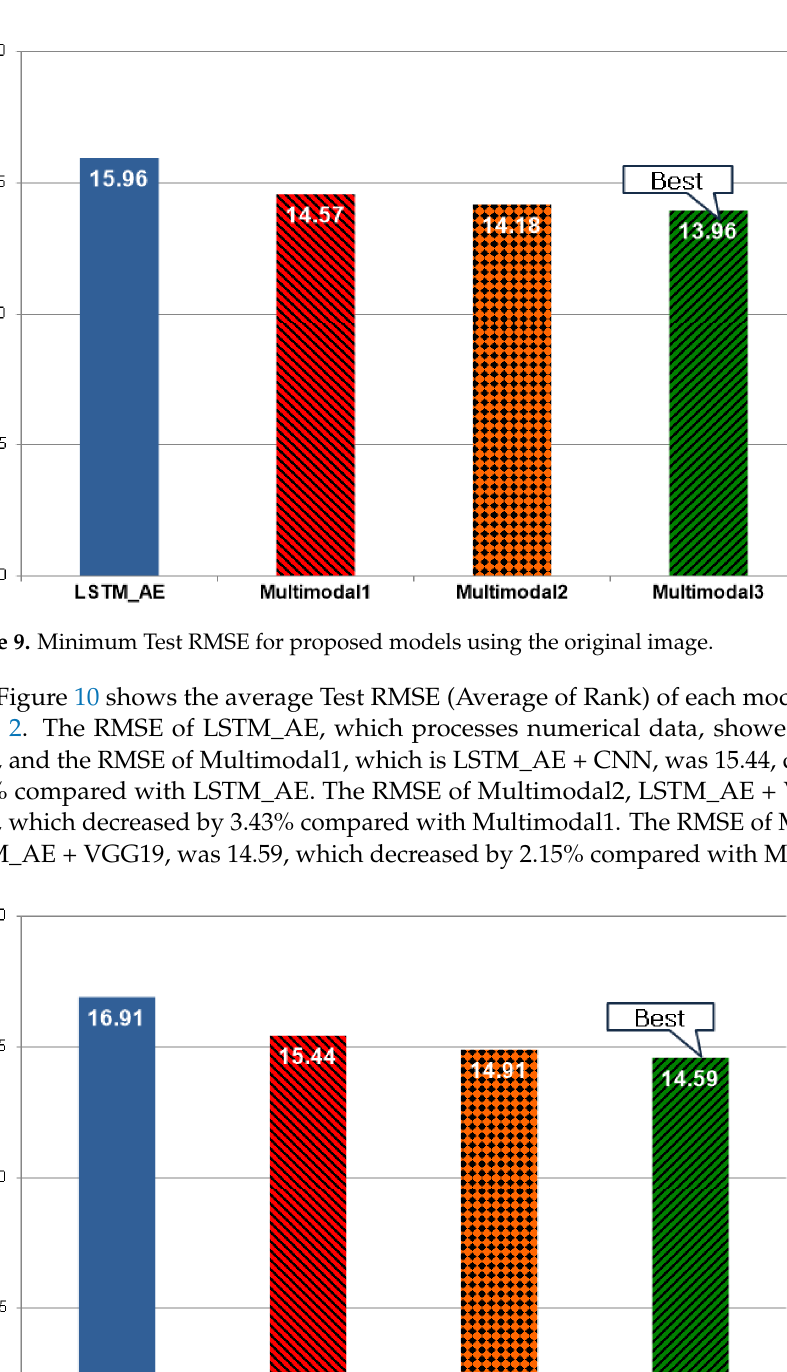
Figure 10. Average Test RMSE for each model using the original image.